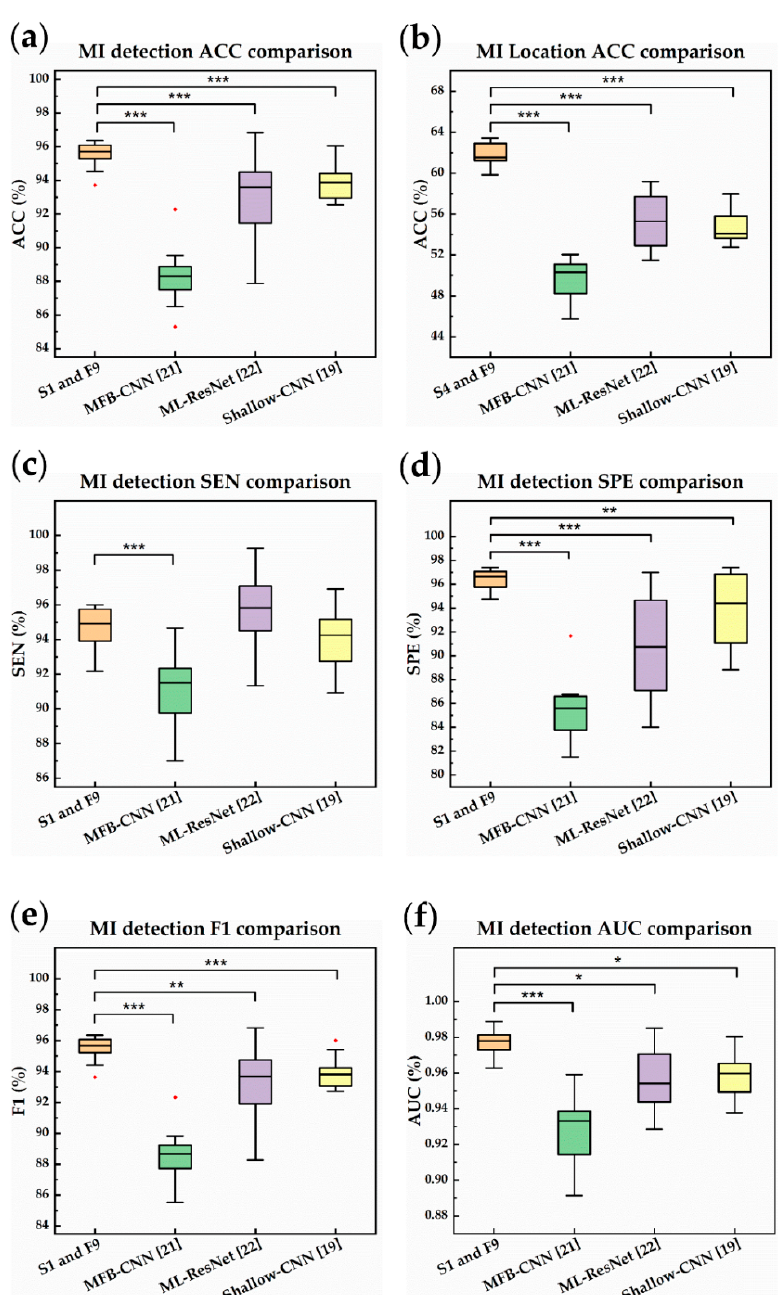
Figure 11. Comparison between the proposed model and literature where 1S indicates models using single-scale features, 9F indicates models using nine filters, and so on. Single star interprets p < 0.05, double star interprets p < 0.01, and triple star interprets p < 0.001. ( a ) MI detection accuracy comparison; ( b ) MI locating accuracy comparison; ( c ) MI detection sensitivity comparison; ( d ) MI detection specificity comparison; ( e ) MI detection F1-score comparison; and ( f ) MI detection area under the receiver operating characteristic curve comparison.